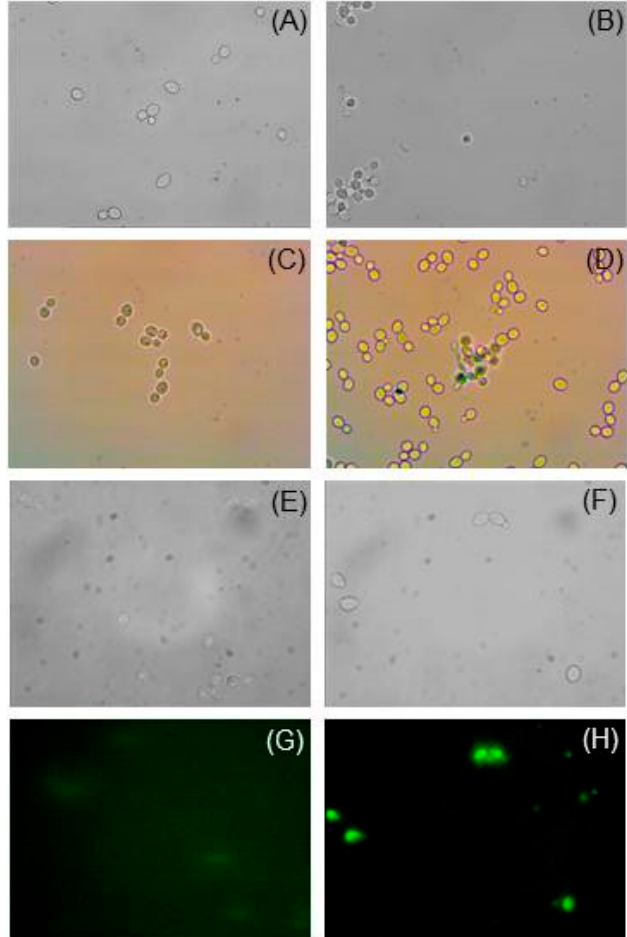
Figure 4. Effect of YBPTI on C. albicans cell morphology. ( A ) Representative optical microscopy images of control C. albicans, and ( B ) the same cells treated with YBPTI (5.7 µ g/mL). ( C ) C. albicans stained with methylene blue ( C ) in the absence or ( D ) presence of YBPTI (5.7 µ g/mL). ( E – H ) C. albicans permeabilization assay using SYTOX green. Representative optical microscopy images of control C. albicans stained with SYTOX green in ( E ) presence or ( F ) absence of YBPTI (5.7 μ g/mL). ( G , H ) shows fluorescence microscopy images of ( E , F ), respectively. In ( E , F ), SYTOX fluorescence emission is shown in green.